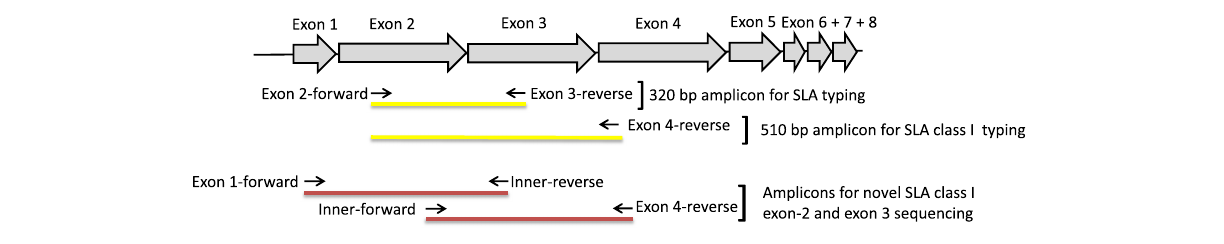
FigUre 1 | Primer location and amplicon coverage. Schematic view of the SLA class I gene and the location of primers used for generation of amplicons to be sequenced (primer sequences are shown in Table 1 ).